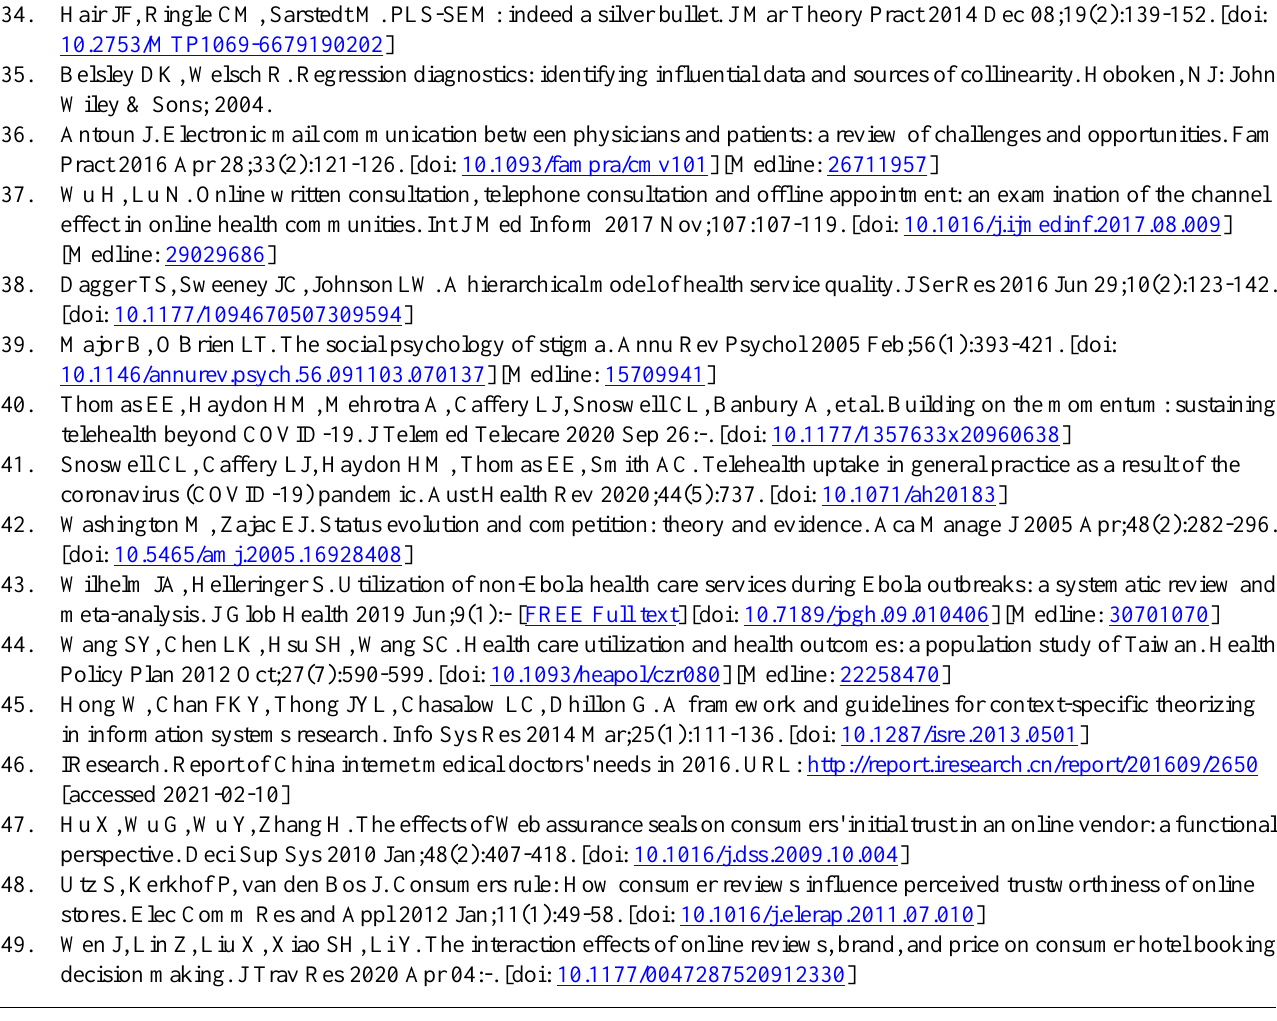
VIF: variance inflation